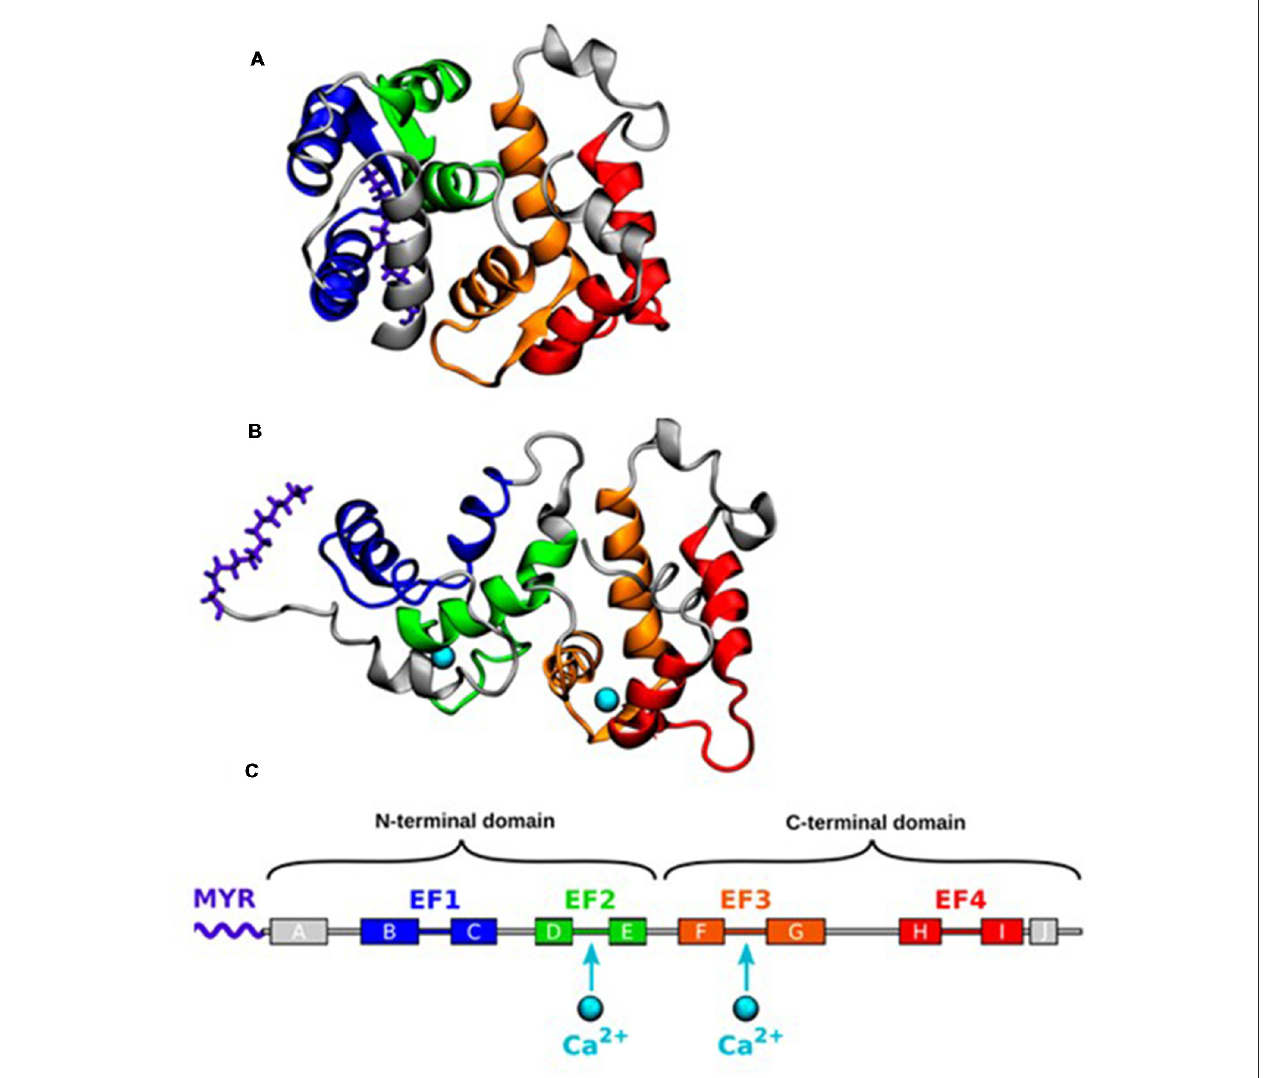
FIGURE 1 | (A) Nuclear magnetic resonance (NMR) structure of the closed state of Recoverin (Rcv) with no calcium bound (geometry no. 1 of PDB ID 1IKU; Tanaka et al., 1995). (B) NMR structure of the open state with two calcium ions (Ca 2+ ) bound (geometry no. 1 of PDB ID 1JSA; Ames et al., 1997). (C) The α -helices of Rcv are labeled alphabetically according to their order in the protein sequence. Adapted with permission from Timr et al. (2018). Copyright © 2018 American Chemical Society.